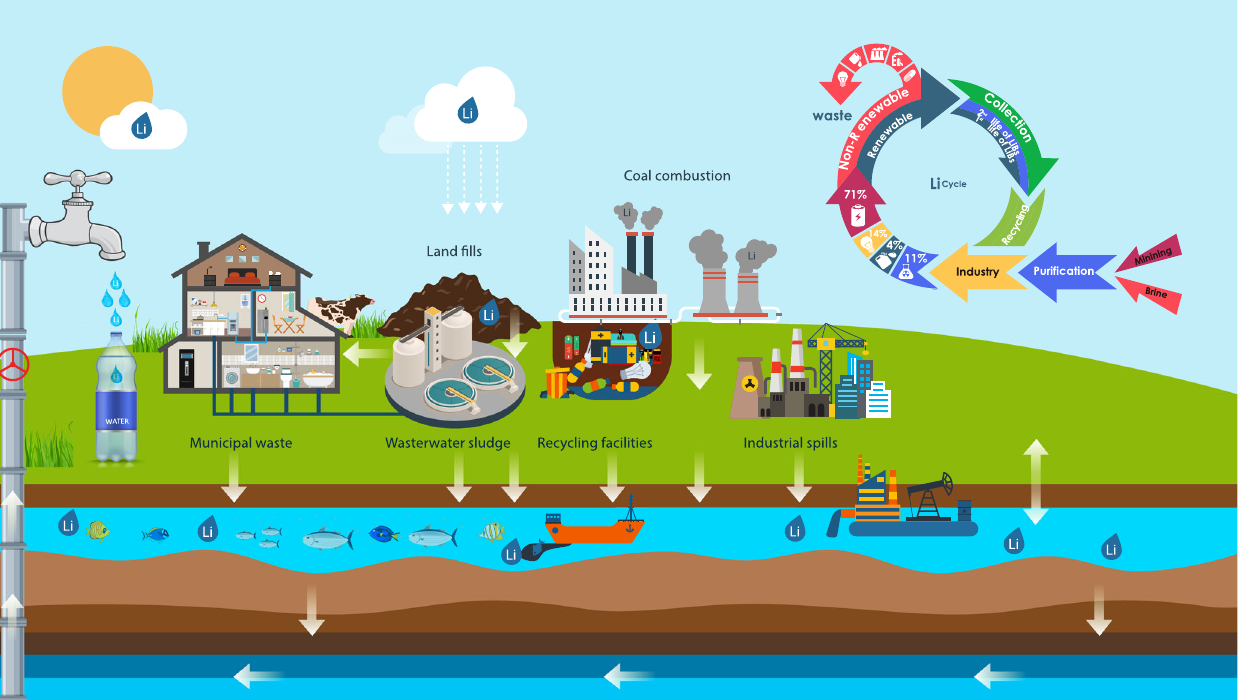
Fig. 3 Illustration of the Li cycle (Li contents come from the Li-ion batteries wastes, coal combustion, municipal waste etc.) with various transport routes along groundwater pathways from possible domestic and industrial sources to human consumption through drinking